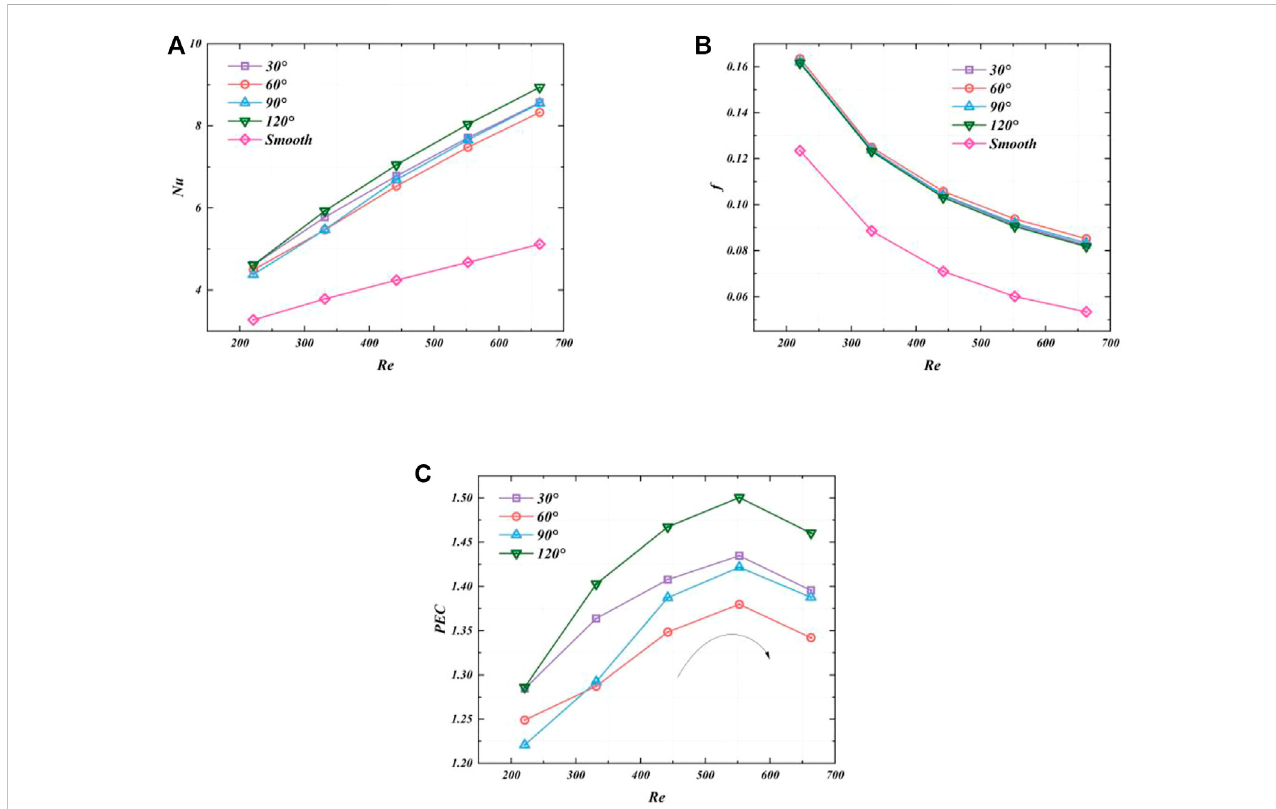
FIGURE 11 Effects of Re on cooling performance (front rotation angle = 30 ° ): (A) Nu; (B) f ; (C)